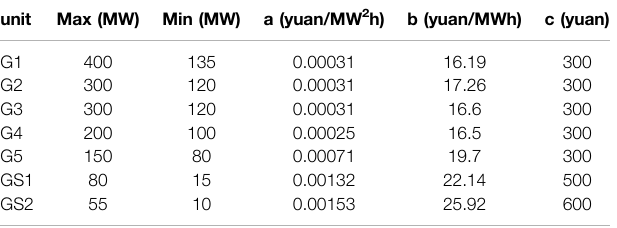
TABLE 1 | Basic data of conventional thermal power units and gas turbines.